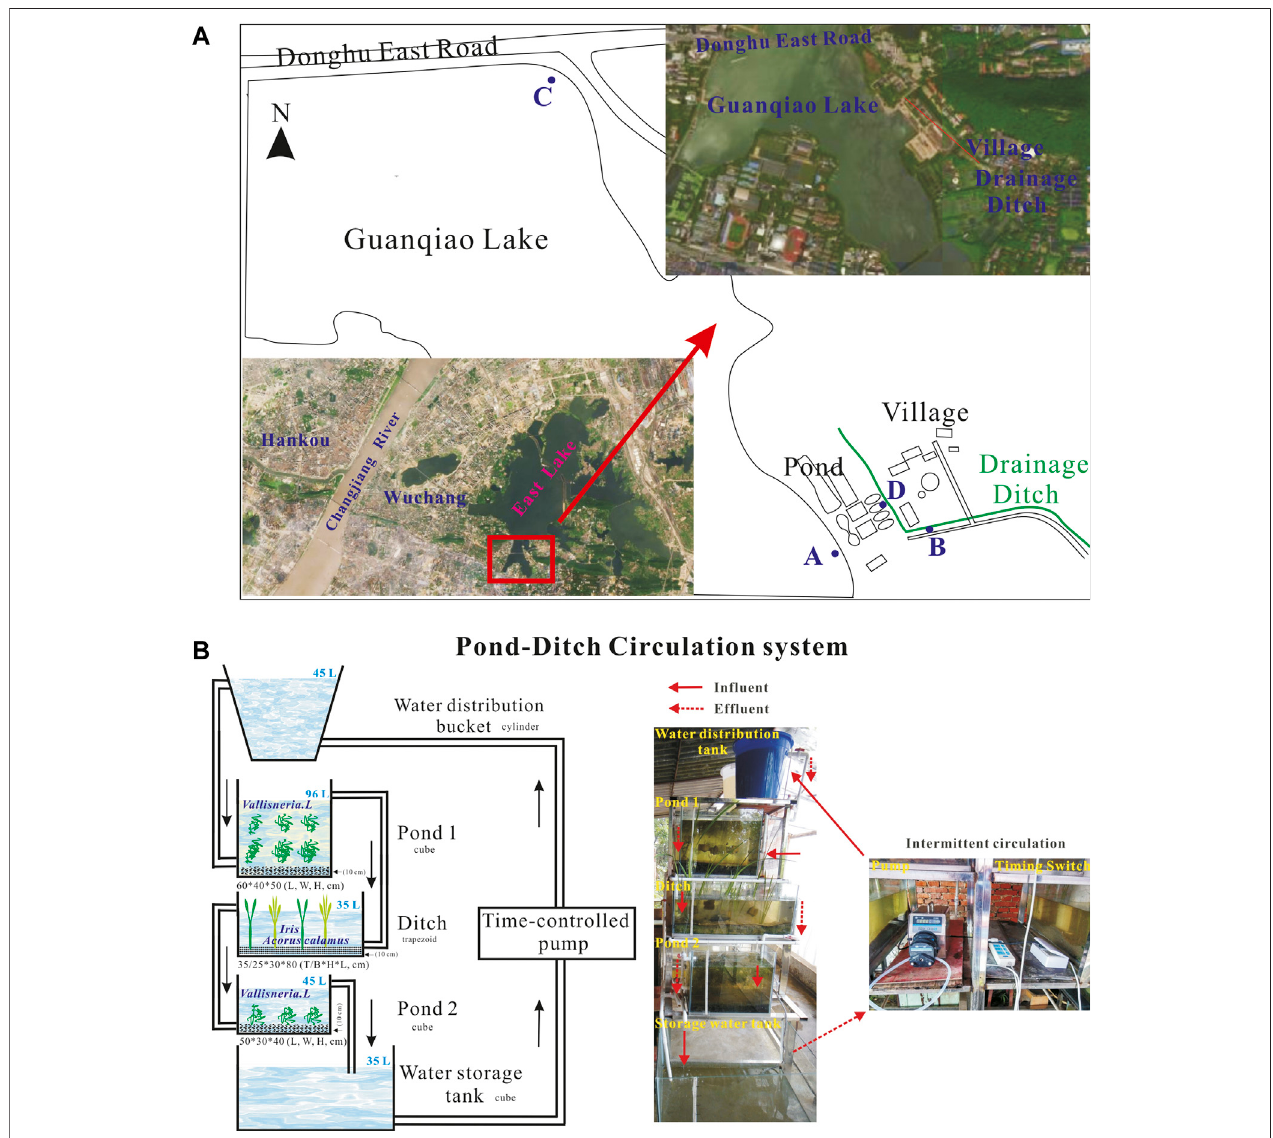
FIGURE 1 | Schematic diagram of the pond-ditch circulation system and sampling sites.